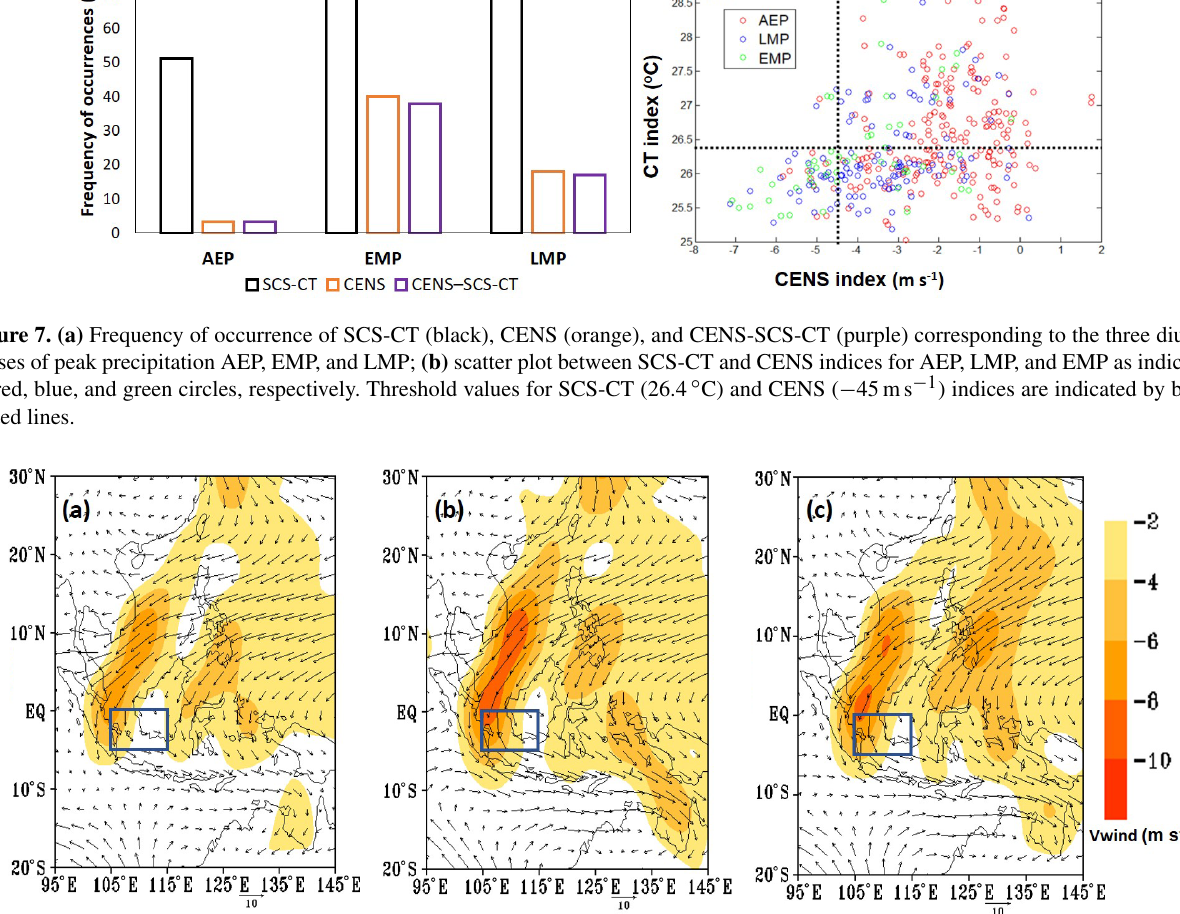
Figure 8. Spatial distribution of mean (composite) 850hPa horizontal wind vectors and magnitude of meridional wind (shaded) correspond- ing to the three diurnal phases of peak precipitation (a) AEP, (b) EMP, and (c) LMP. The dark-blue solid rectangle represents the CENS index area (following Hattori et al.,